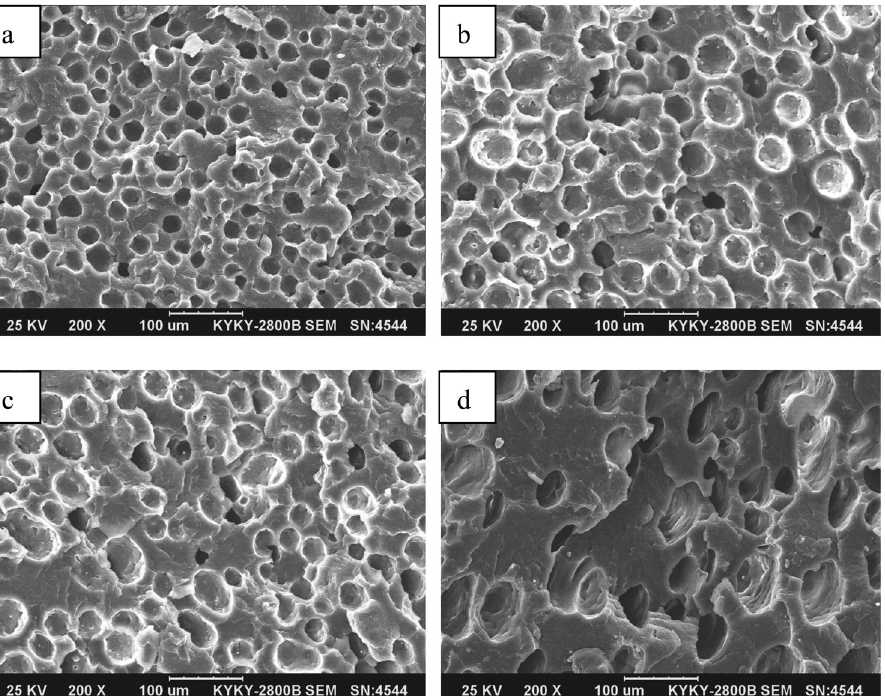
Figure 6: Freeze - fracture SEM images of the PP foams with various cell size distributions. Scale bar: 100 μ m. Cell size distribution: ( a ) 14 μ m, (